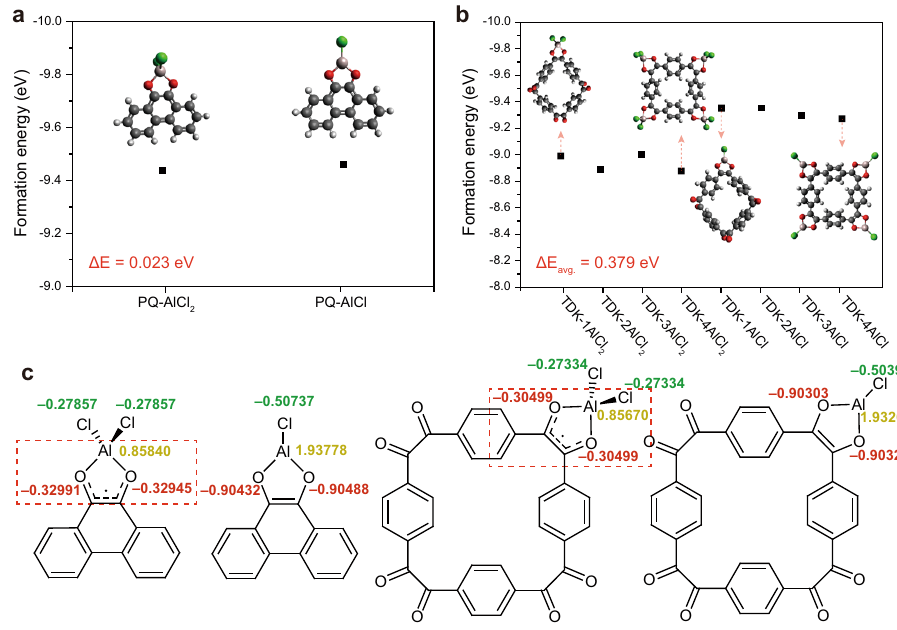
Fig. 2 Thermodynamic stability of PQ and TDK when bound with monovalent (AlCl 2 + ) or divalent (AlCl 2 + ) carrier ions. a , b Formation energies of a PQ and b TDK when bound with AlCl 2 + or AlCl 2 + complex ions. The four different states correspond to the cases when different numbers of AlCl 2 + or AlCl 2 + ions are bound. The optimised molecular structures of selected TDK- n AlCl 2 or TDK- n AlCl combinations are presented. c Atomic charge analysis of PQ and TDK when bonded to a single AlCl 2 + or AlCl 2 + ion.